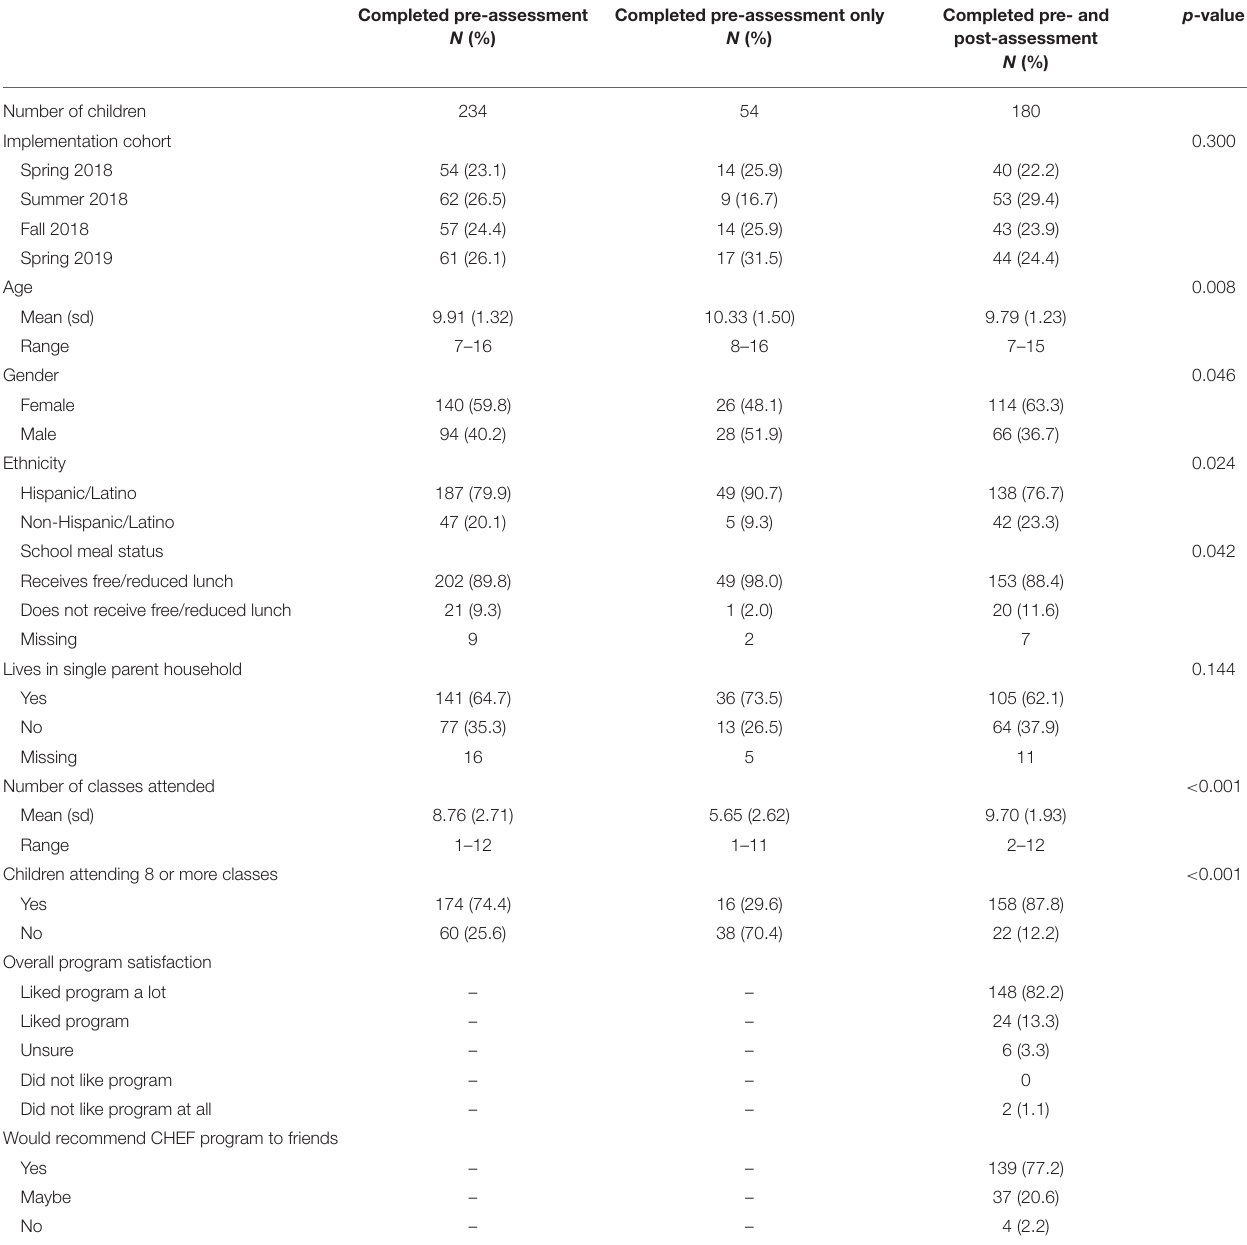
TABLE 1 | Children’s sociodemographic characteristics, program participation, and program satisfaction of children who completed the pre-assessment survey, those who completed both the pre- and post-assessment surveys and those who only completed the pre-assessment survey. Completed pre-assessment Completed pre-assessment only Completed pre- and N (%) N (%)